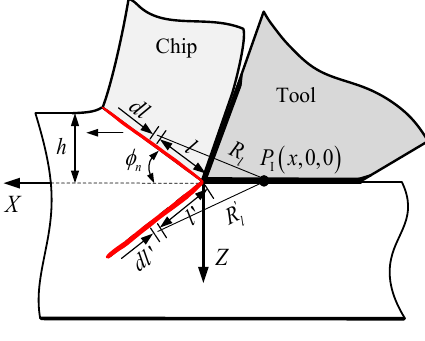
Figure 3. Heat source in the PSZ.